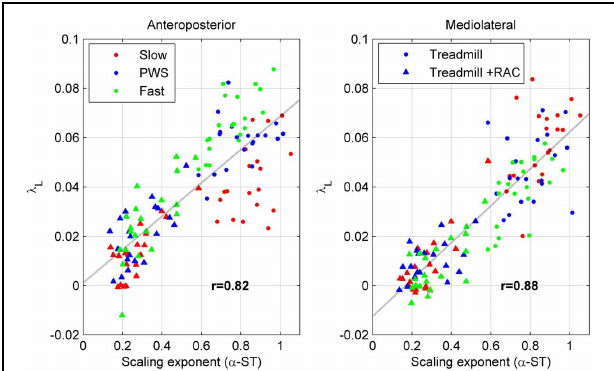
FIGURE 5 | Scatter plot of statistical persistence and long-term local dynamic stability (LDS). Twenty subjects walked on a treadmill at slow speed (red), preferred walking speed (PWS, blue), and fast speed (green) without (circles) and with (triangles) rhythmic auditory cueing ( N = 120). Detrended fluctuation analysis was used to determine the scaling exponents of the time series of stride time ( α -ST, see Appendix B), which are plotted along the horizontal axis. Divergence exponents ( λ L , see Figure 4 ) are plotted along the vertical axis. The discontinuous line is the best linear fit (least squares method). Values are the Pearson’s correlation coefficients (r).